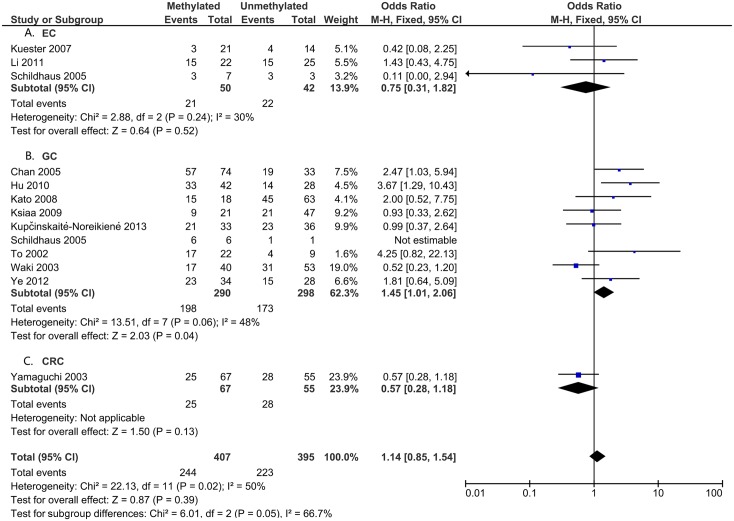
DAPK1 methylation and N stage (positive vs. negative) in: A. EC; B. GC; and C. CRC.